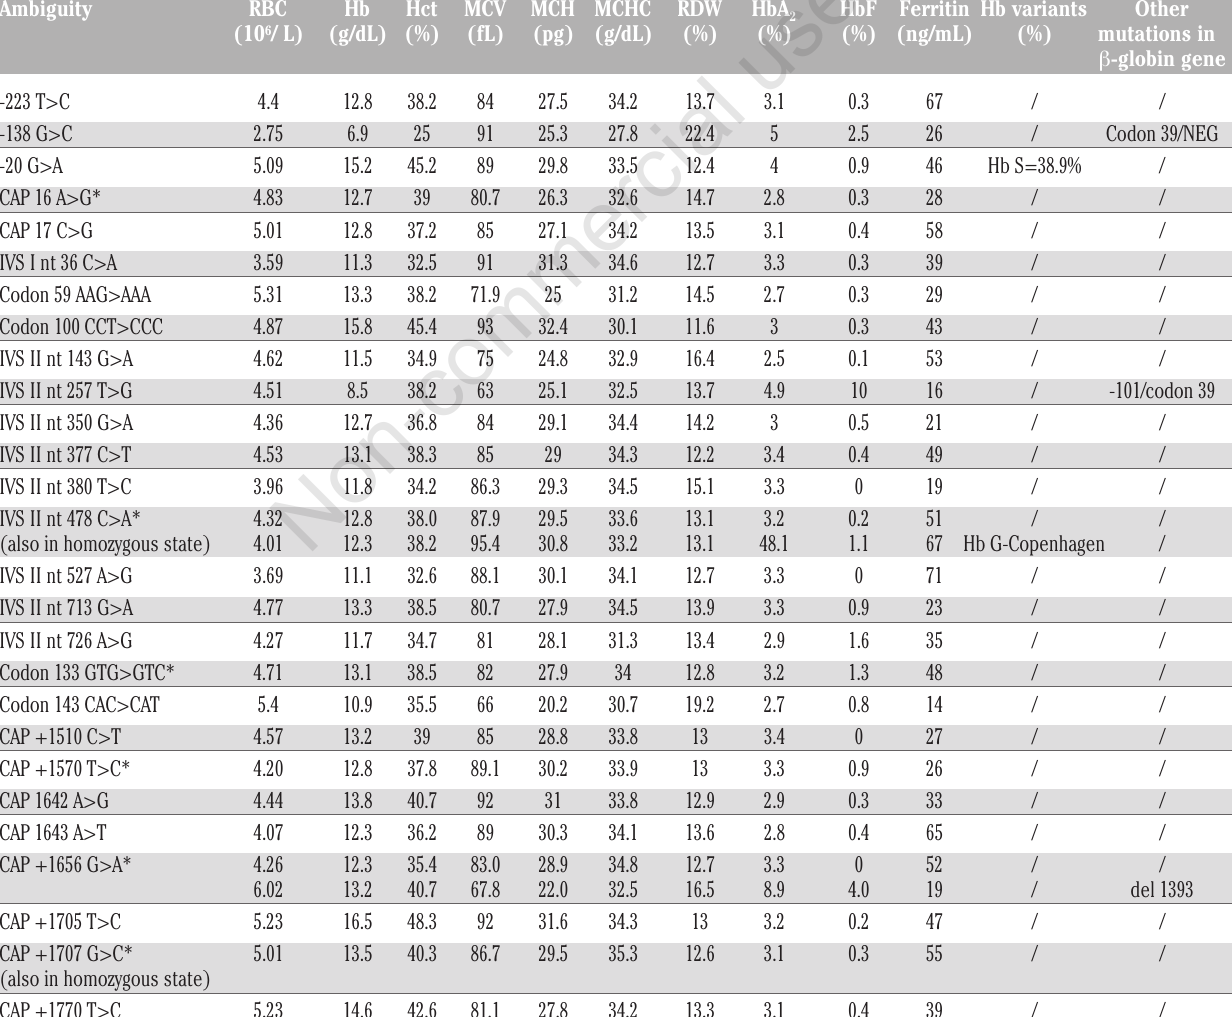
Table 3. Nucleotide substitutions identified in heterozygous state and related phenotypes, and cases of compound heterozygosity with other alterations in β -gene, except for IVS II nt 478 (C>A) and CAP +1707 (G>C) that were found in associations with many different globin gene changes without further